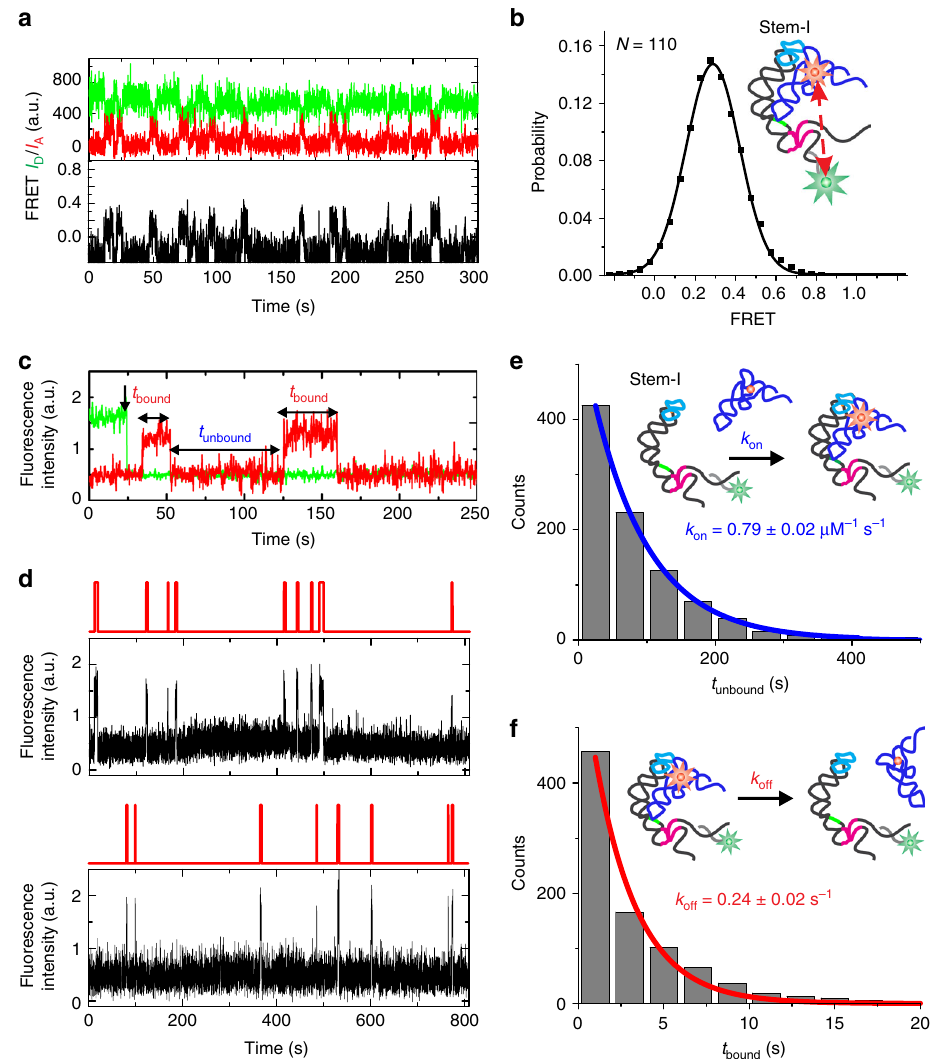
Fig. 2 smFRET and kinetic analysis of tRNA binding to Stem-I. a Example smFRET trace of Cy5-labeled tRNA Gly binding to Stem-I hybridized with Cy3- labeled DNA oligonucleotide at the 3 ′ -end. Green, Cy3 intensity; red, Cy5 intensity; black, FRET ef fi ciency. b Population FRET histogram generated from the binding events and fi t with a single Gaussian function (black). The mean FRET value given by the center of the peak provides an estimate of the distance between the fl uorophores, which in this example is between the base of Stem-I and U46 of the bound tRNA. c Example binding trace showing Cy3 intensity that photobleaches in a single-step indicative of one T-box riboswitch molecule, and abrupt increases in Cy5 intensity, indicative of tRNA binding and dissociation events from which dwell times in bound and unbound states, t bound and t unbound , can be obtained. d Representative single-molecule traces showing tRNA binding to Stem-I. The Cy5 signal is shown in black and a two-state hidden Markov model (HMM) idealized trace is shown on top in red. Dwell-time histograms for e t unbound and f t bound were fi t with single-exponential functions (blue and red), to estimate the rate constants, k on and k off , respectively. Errors are s.d. of at least three independent